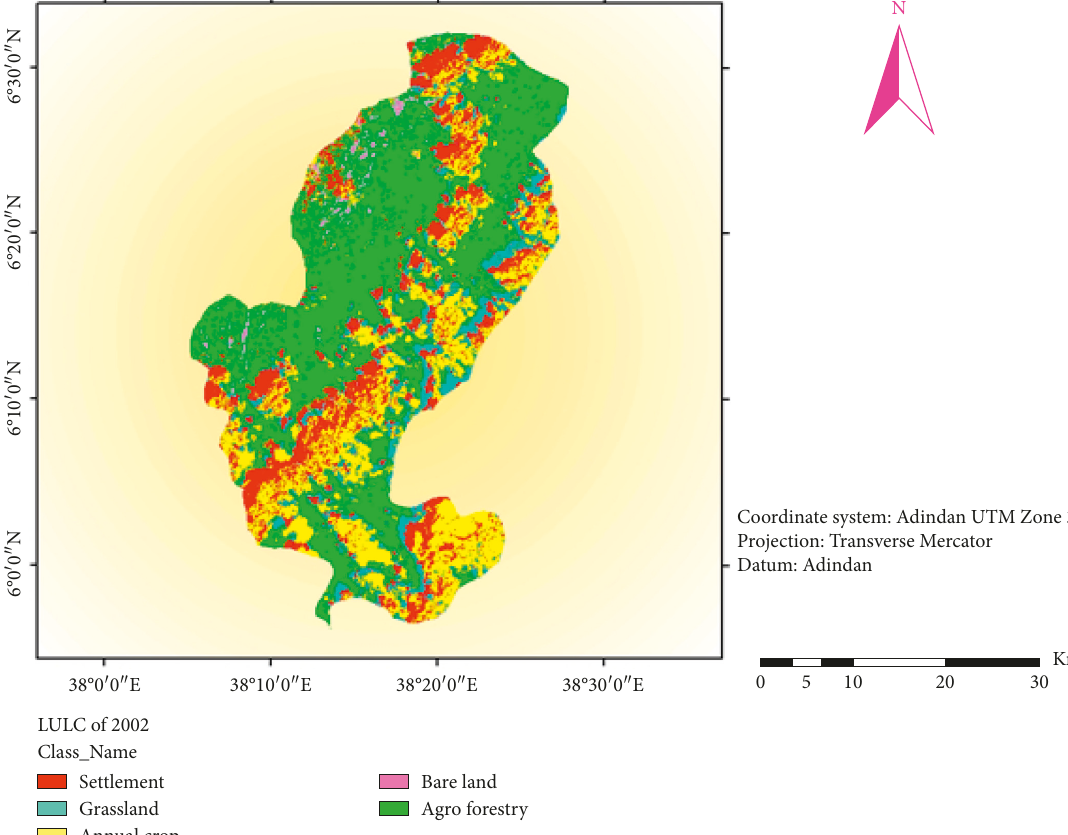
Figure 10: Land use land cover of map of